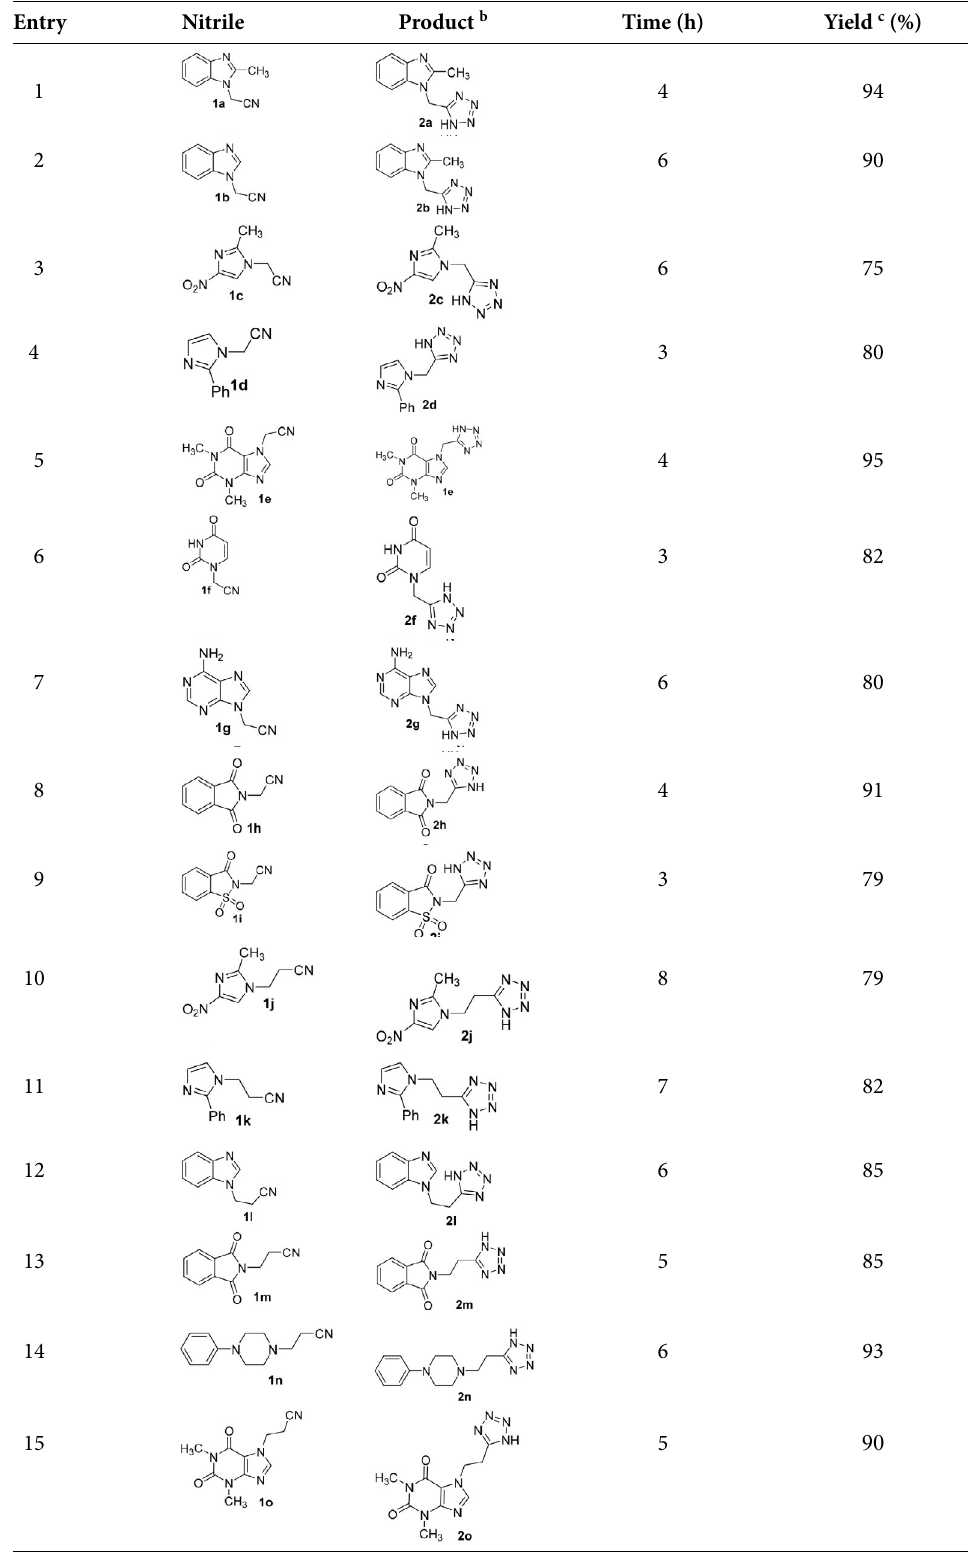
Table 4. The synthesized new 1 H -tetrazoles using SiO 2 -Cu-BDACDABSBC a